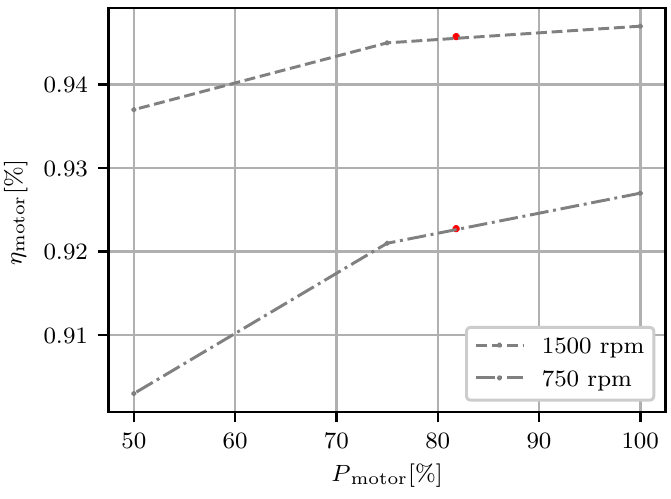
Figure 3. Efficiencies of the Dahlander motors driving the fans. The working point is indicated with a red